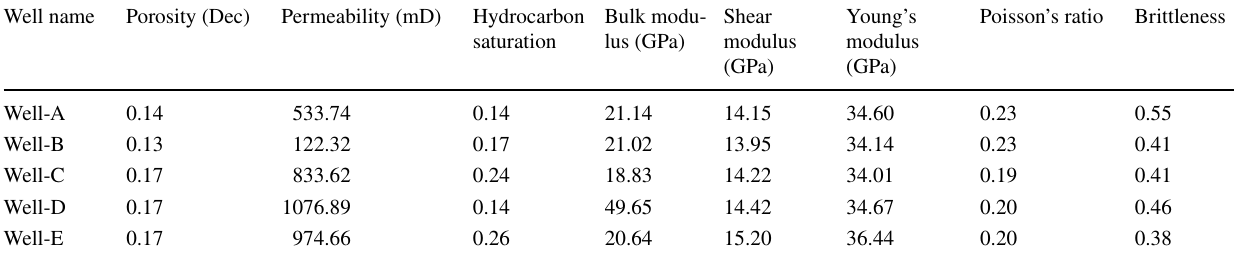
Table 2 Average values of petrophysical and geomechanical parameters of the studied